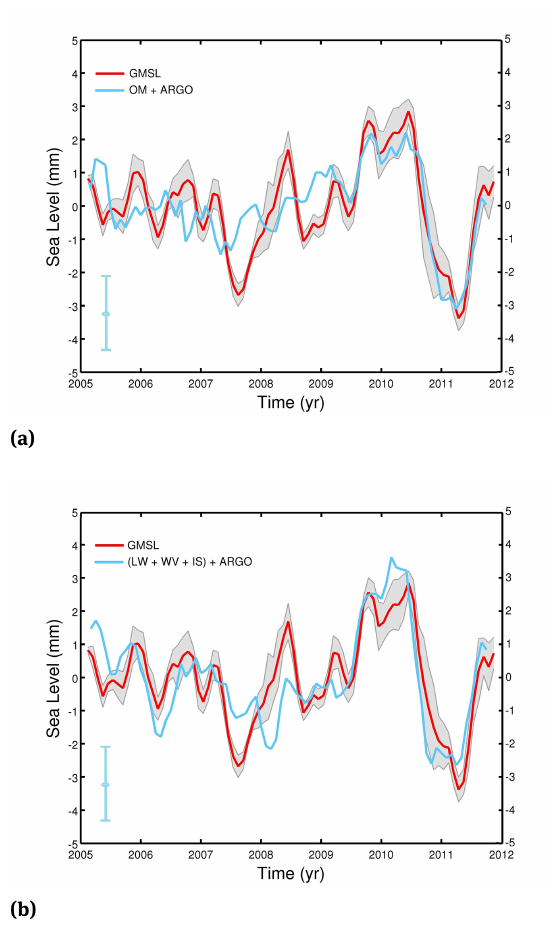
Fig. 3. a) Interannual GMSL (red curve) on which are superimposed the global mean ocean mass from GRACE (blue curve) and the sum ‘land water storage + water vapor + interannual ice sheet, IS, com- ponent’ (green curve). Vertical bars represent errors on monthly val- ues of GRACE-based ocean mass and sum of mass components; b) Interannual GMSL (red curve) on which are superimposed the steric contribution from Argo (black curve). The interannual ice sheet com- ponent is also shown (green curve). The vertical bar represents the error on monthly values of the Argo-based steric sea level.